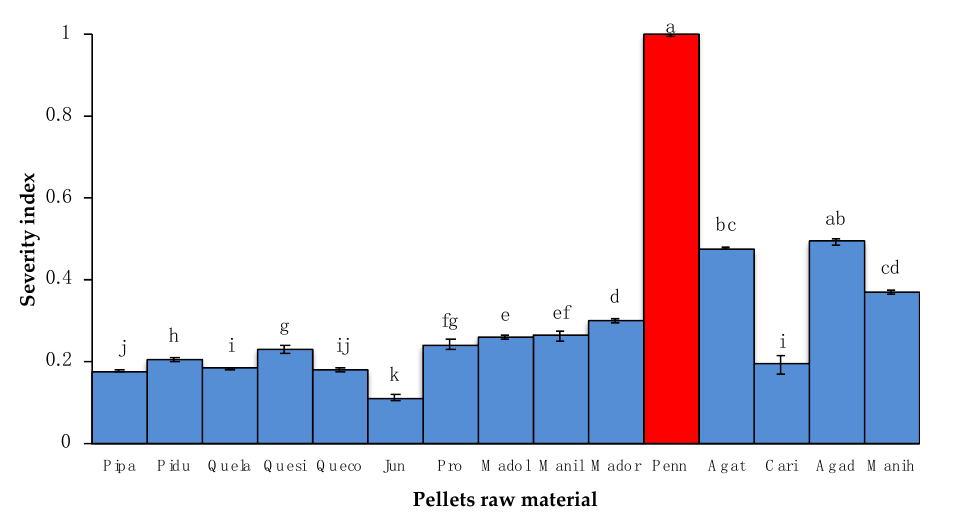
Figure 9. Severity index calculated based on the BioSlag test. The lines above the bars show the standard deviation, species with different letters are statistically different ( p < 0.05). The bar in red color corresponds to biomass pellets with high fusibility problems.